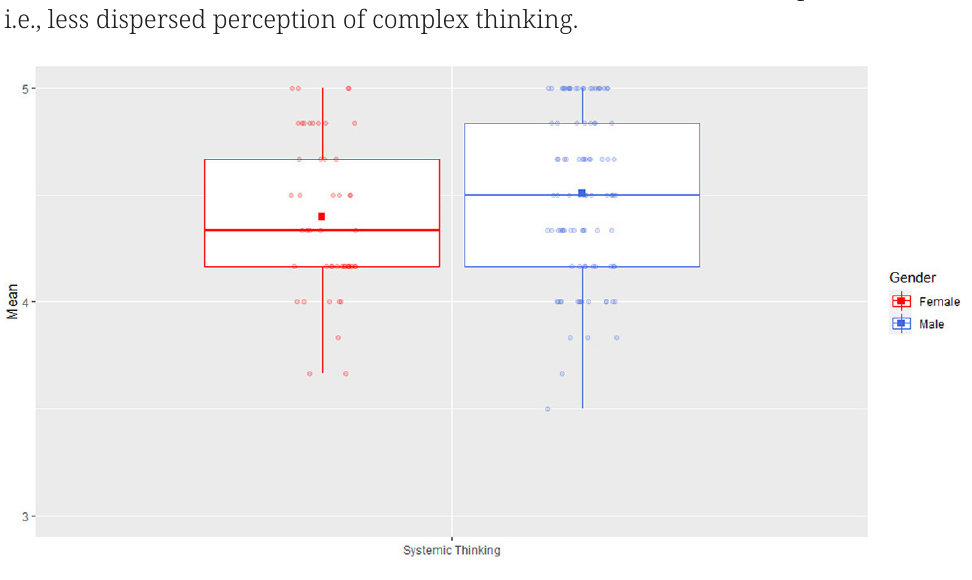
Fig. 5. Boxplot analysis of systemic thinking sub-competency by gender